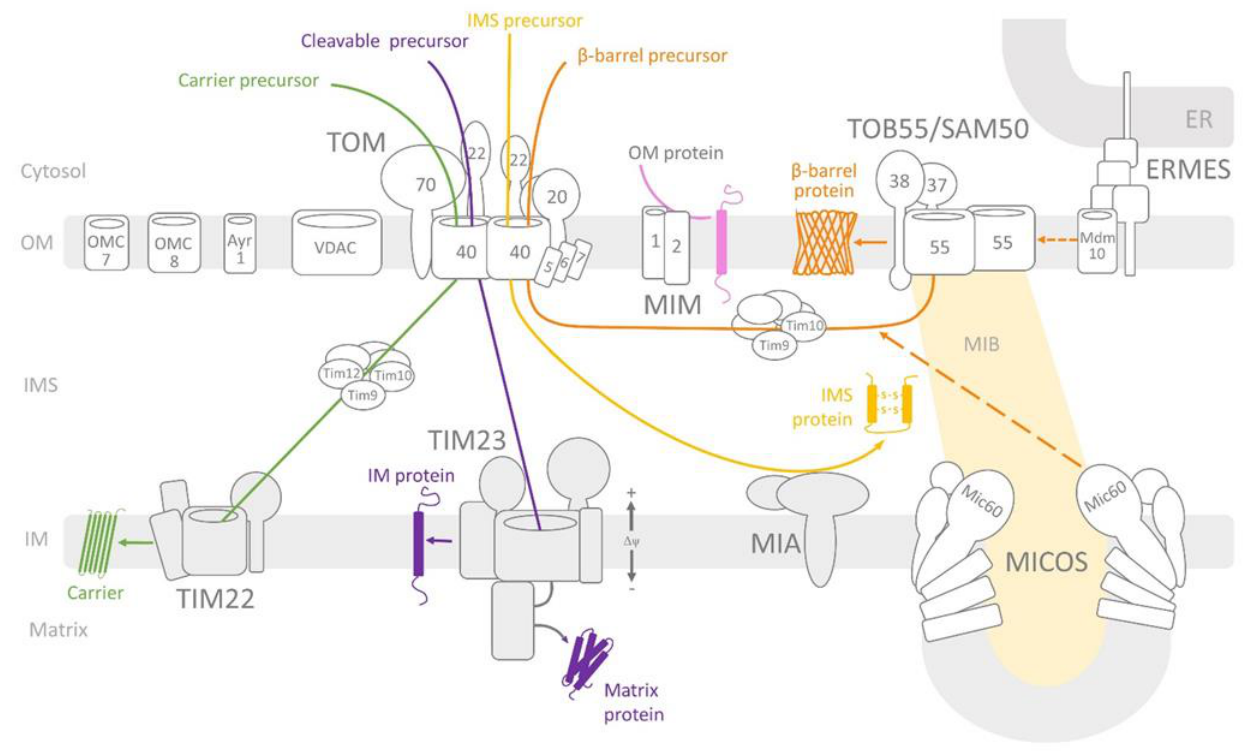
Figure 1. Overview of protein import into mitochondria. The TOM complex recognises most of the mitochondrial preproteins via its receptors (i.e., Tom20, Tom22 and Tom70) and imports across the outer membrane through the Tom40 channel (dimer). Small TOM subunits (i.e., Tom5, Tom6 and Tom7) stabilise the TOM complex. β-barrel precursors (i.e., Tom40, Tob55/Sam50, VDAC and Mdm10) are inserted into the outer membrane by the TOB/SAM complex, which consists of the protein channel Tob55/Sam50 (dimer) and receptors Tob38 and Tob37. The mitochondrial contact site and cristae organising system (MICOS) complex supports the insertion of the β-barrel proteins into the OM. The dynamic structure of TOB/SAM and MICOS is called mitochondrial intermembrane space bridging (MIB). α-helical precursors are inserted into the OM by the MIM complex (Mim1 and Mim2). The ERMES complex links the mitochondria and endoplasmic reticulum (ER) and supports the topogenesis of the mitochondrial outer membrane β-barrel proteins/sorting and assembly machinery (TOB/SAM) complex. The precursor targeted into the intermembrane space engages the MIA complex. TIM23 is responsible for import across the IM or into the mitochondrial matrix. TIM22 inserts carrier proteins into the IM. Voltage-dependent anion-selective channel (VDAC) is responsible for metabolite transport. Ayr1, OMC7 and OMC8 are the channels of unknown substrates. OM—outer membrane; IM—inner membrane; IMS—intermembrane space; ER—endoplasmic reticulum.